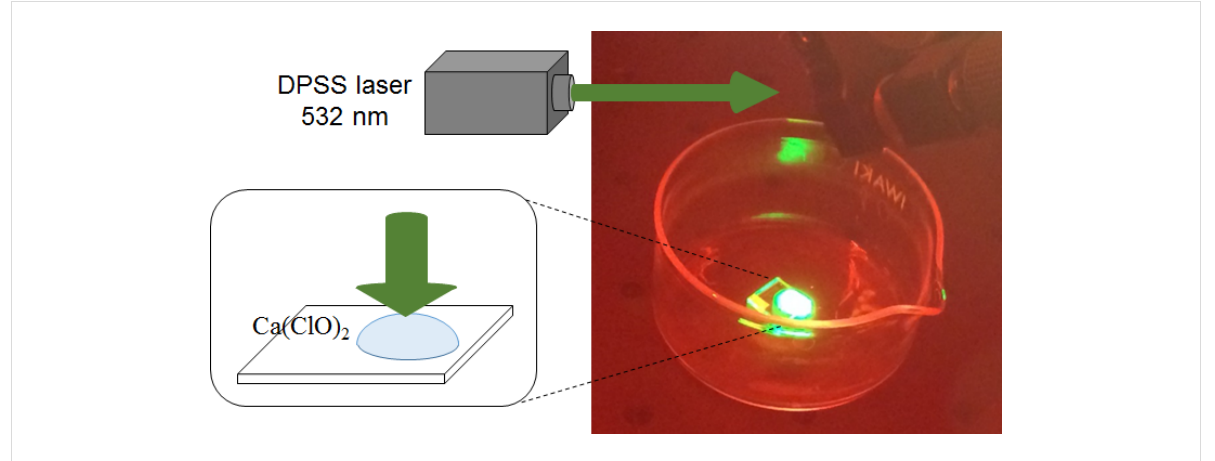
Figure 2: Experimental setup for the near-field wet etching technique.